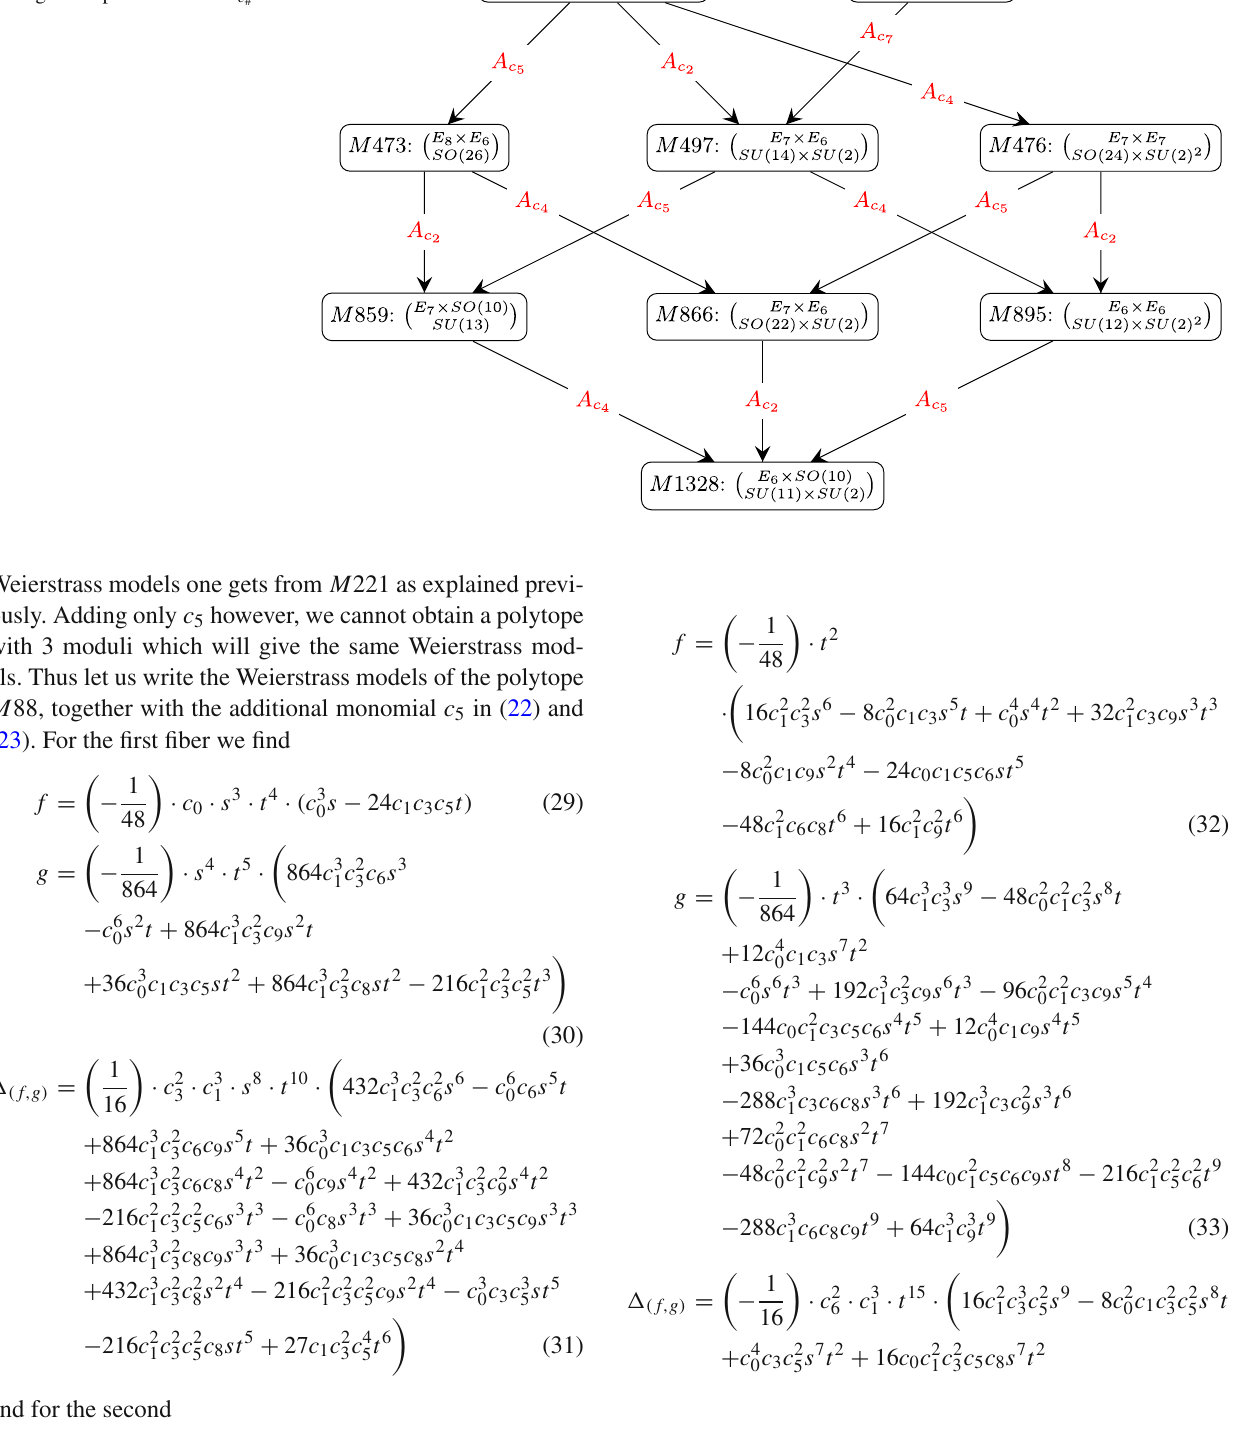
Fig. 6 Links between various reflexive polyhedra. Going upward from M 1328 amounts to removing points in the polytope M 1328, or equivalently monomials in the hypersurface equations (22) and (23). Going downward corresponds to adding a complex modulus A c